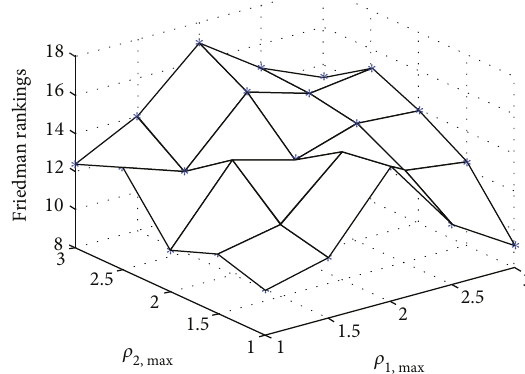
Figure 7: Average Friedman rankings for contraction criteria combinations on 25 benchmark